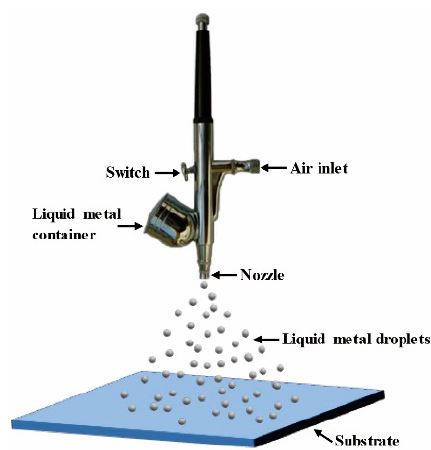
Figure 1. Schematic diagram of the preparation of liquid metal (LM) droplets and their deposition on a supporting substrate to produce a film.